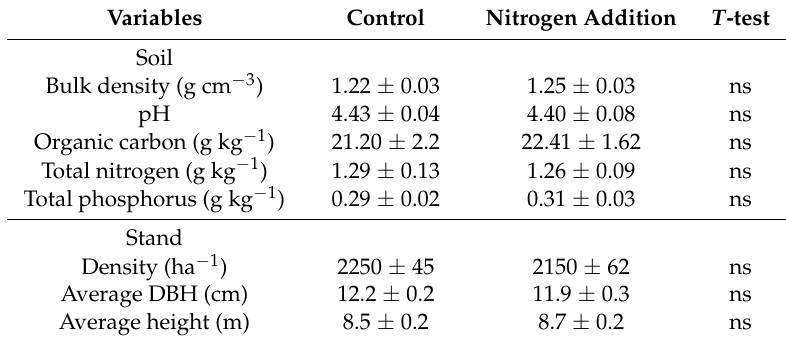
Table A1. General properties of the Chinese fir forest plantation before experimental treatment in 2011.